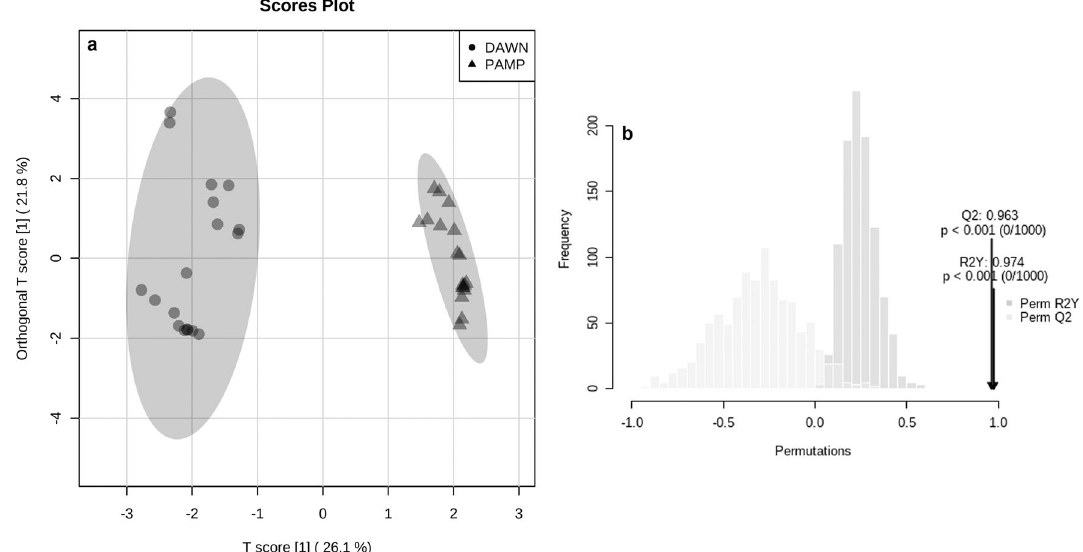
Figure 8. Score plots of orthogonal projection to latent structure discriminant analysis (OPLS-DA) ( a ) and model validation by the Permutation test (1000 permutations) ( b ) derived from LC–MS/MS dataset of two rice cultivars of contrasting susceptibility to the South American rice water weevil Oryzophagus oryzae (Resistant: DAWN = ‘Dawn’; Susceptible: PAMP = ‘BRS Pampa CL’). The P value based on permutation was P < 0.001 (0/1000).